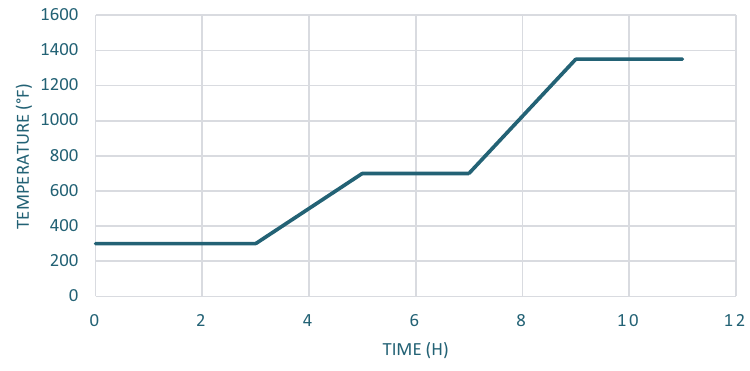
Figure 2. 3D Systems FabPro 1000 prototyping resin burnout